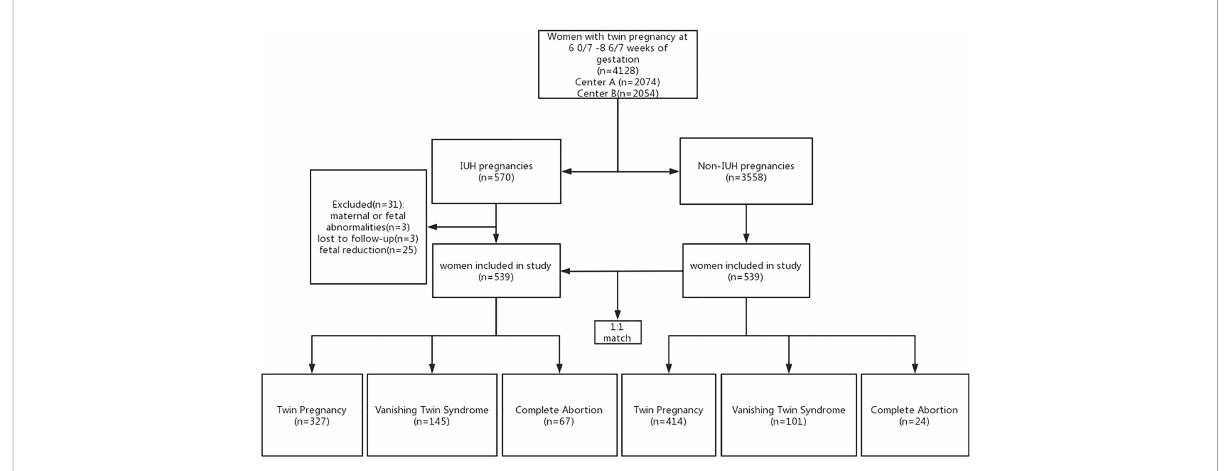
FIGURE 1 Flowchart showing the study selection of women with or without an IUH pregnancy and the incidence of pregnancy outcomes categorized by the number of live births. Center A, Peking University Third Hospital; Center B, Xiamen University Women and Children ’ s Hospital; IUH, intrauterine